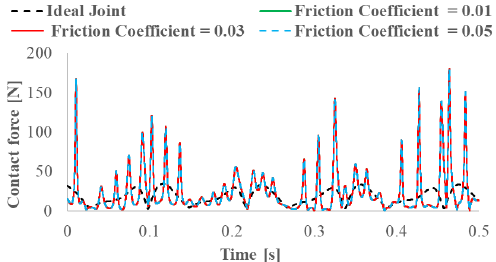
(a) Contact force R 3 .